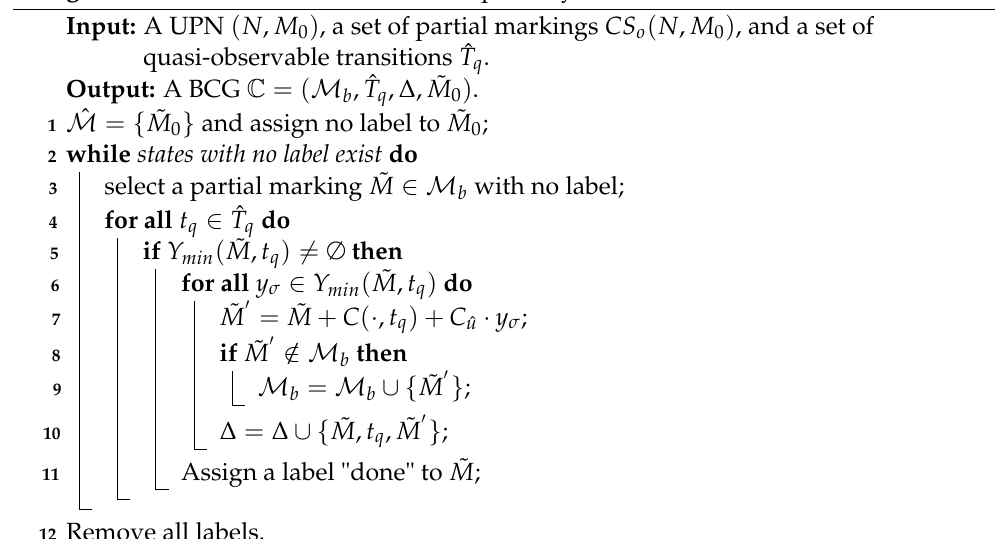
Algorithm 2: Construction of BCG for a partially observed